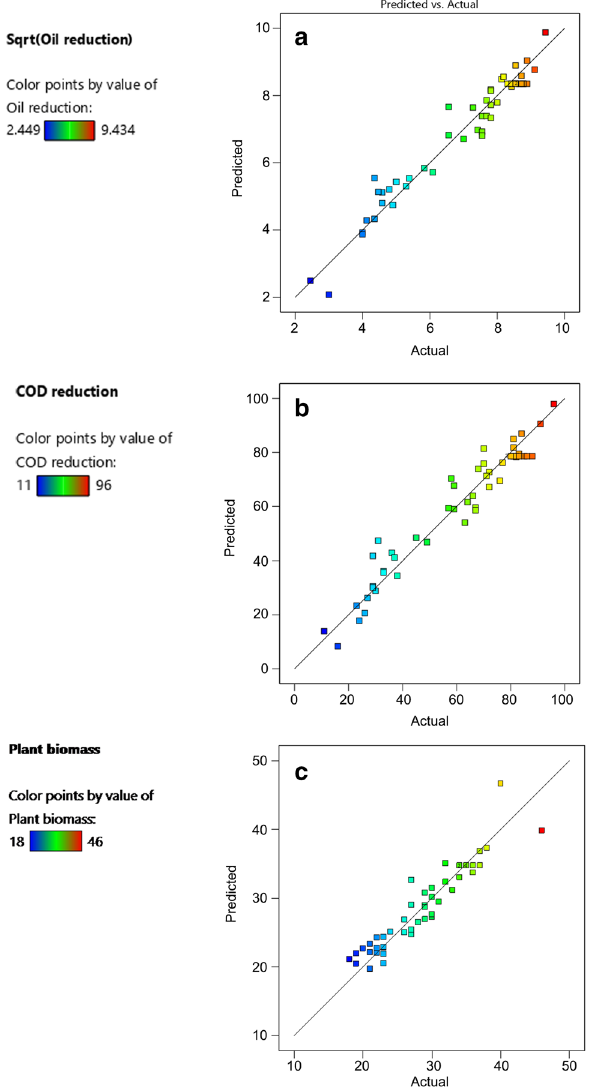
Figure 2. ( a–c ) Correlation between the actual and predicted ( a ) hydrocarbon reduction, ( b ) COD reduction, and ( c ) increase in plant